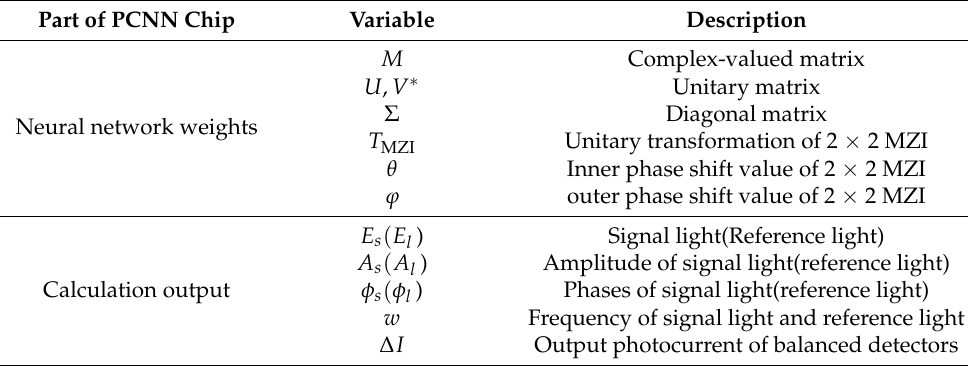
Neural network weights